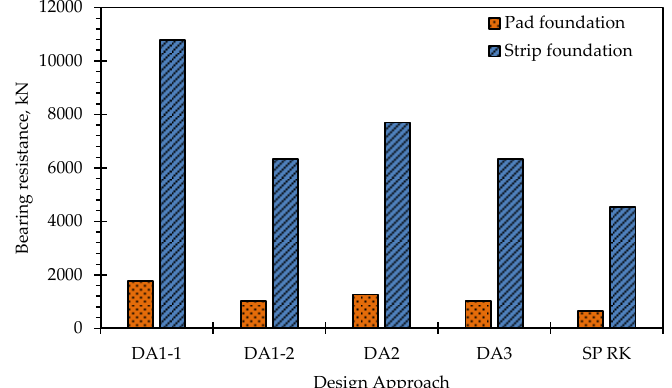
Figure 5. Comparison of the values of bearing capacity for pad and strip foundations adhering to Kazakhstani and European approaches.